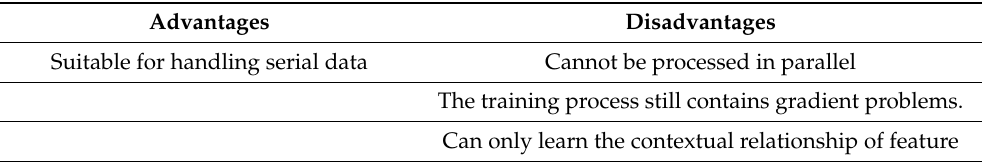
Table 5. The advantages and disadvantages of LSTM.